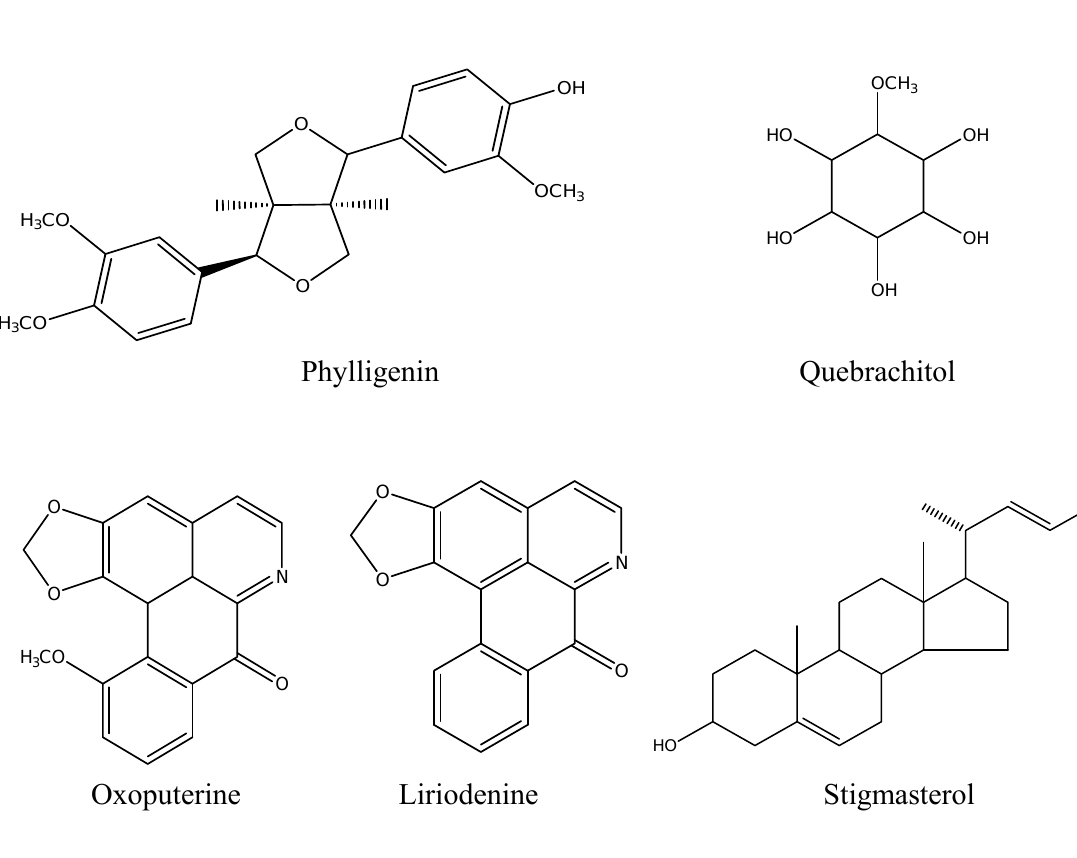
Figure 1. Structures of compounds from Mitrephora